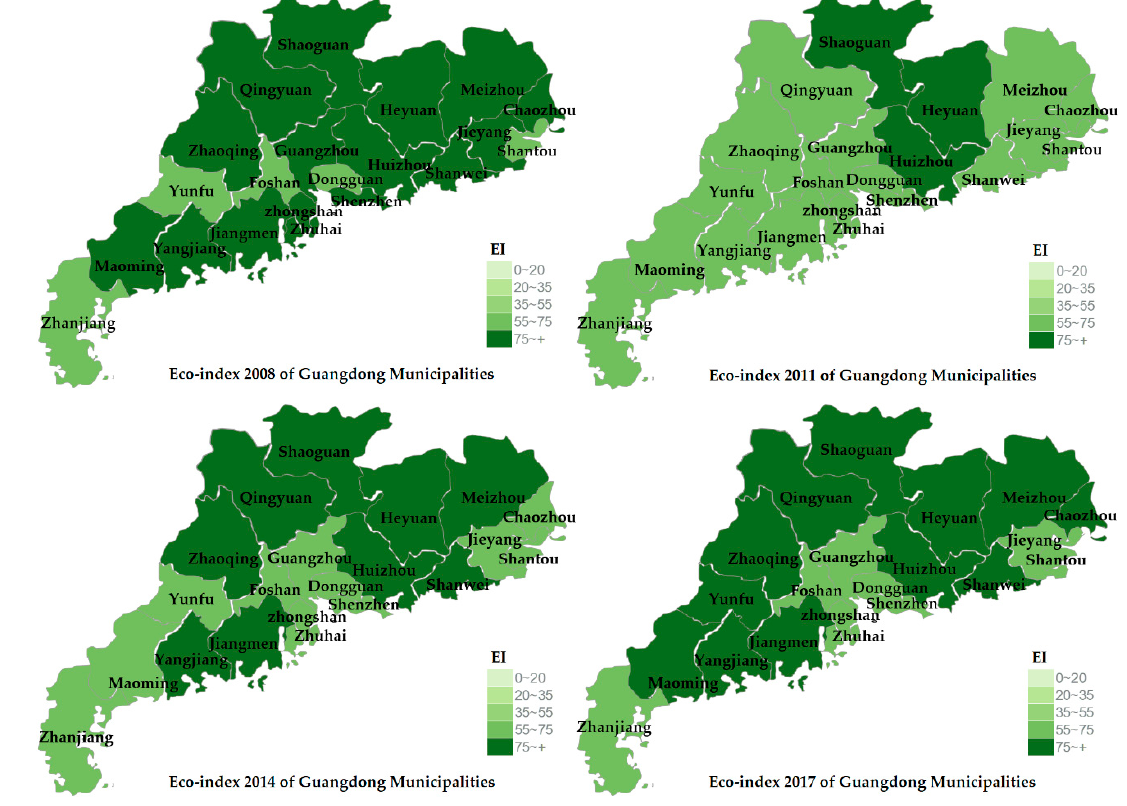
Figure 2. Ecological environment in Guangdong Province.